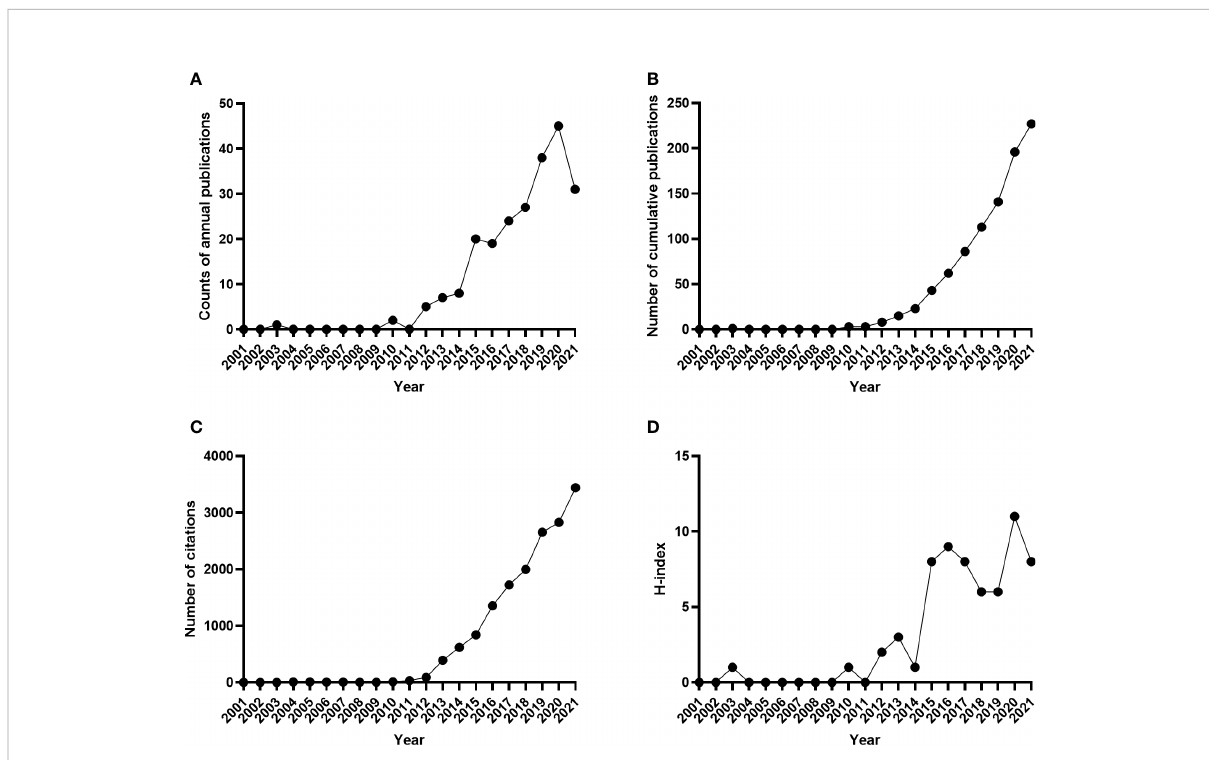
FIGURE 2 Trends in the number of publications from 2001-2021 in the fi eld of FMT. (A) The annual number of published articles; (B) The number of annual cumulative articles; (C) The annual citation number of publications; (D) The annual H-index values of